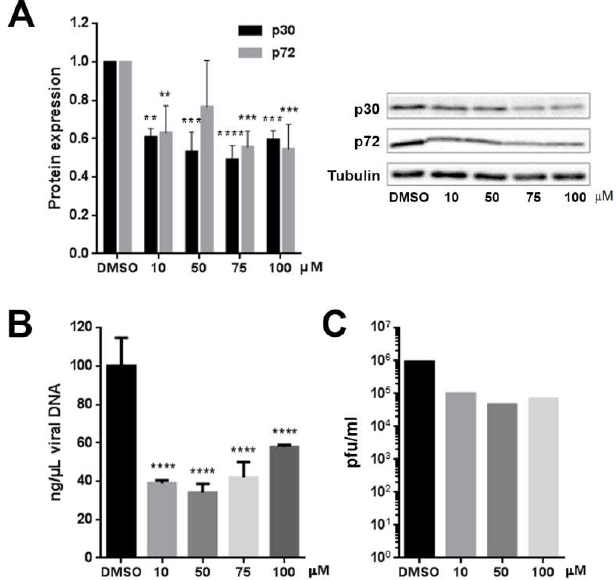
Figure 4. ( A ) ITZ treatment reduced viral protein expression by WB after Ba71V infection. ( B ) ASFV genome copy number reduction by PCR real time and ( C ) Effect of ITZ on virus titers by plaque assay in Ba71V infected Vero cells at 24 hpi. Error bars indicate S.D. from three independent experiments. Statistically significant differences are indicated by asterisks (**** p <0.0001, *** p < 0.001, ** p < 0.01).